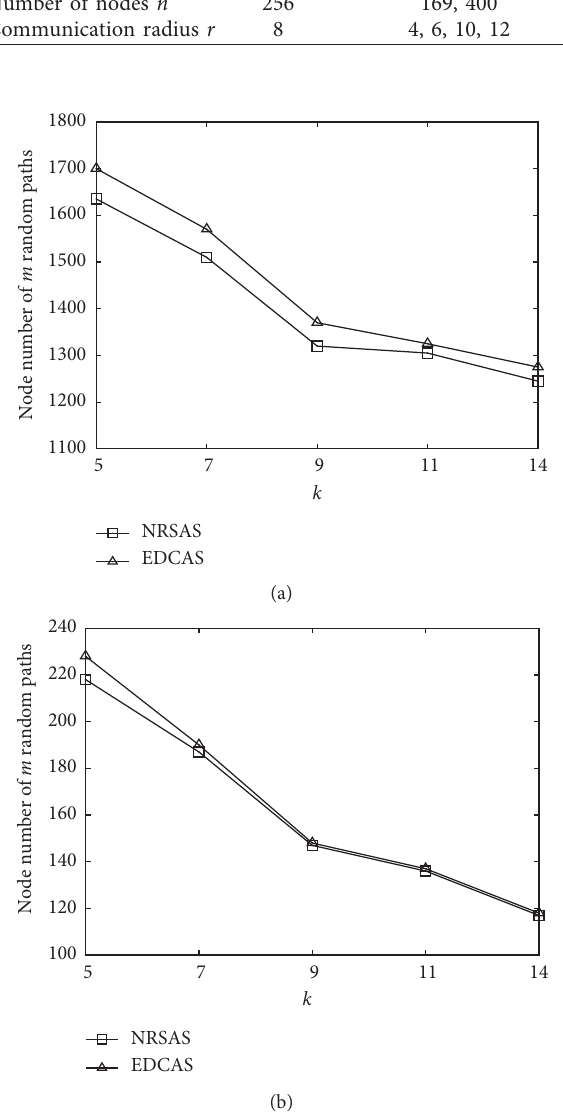
Figure 10: The effect of the sparsity on the random path. (a) Synthetic dataset. (b) IntelLab